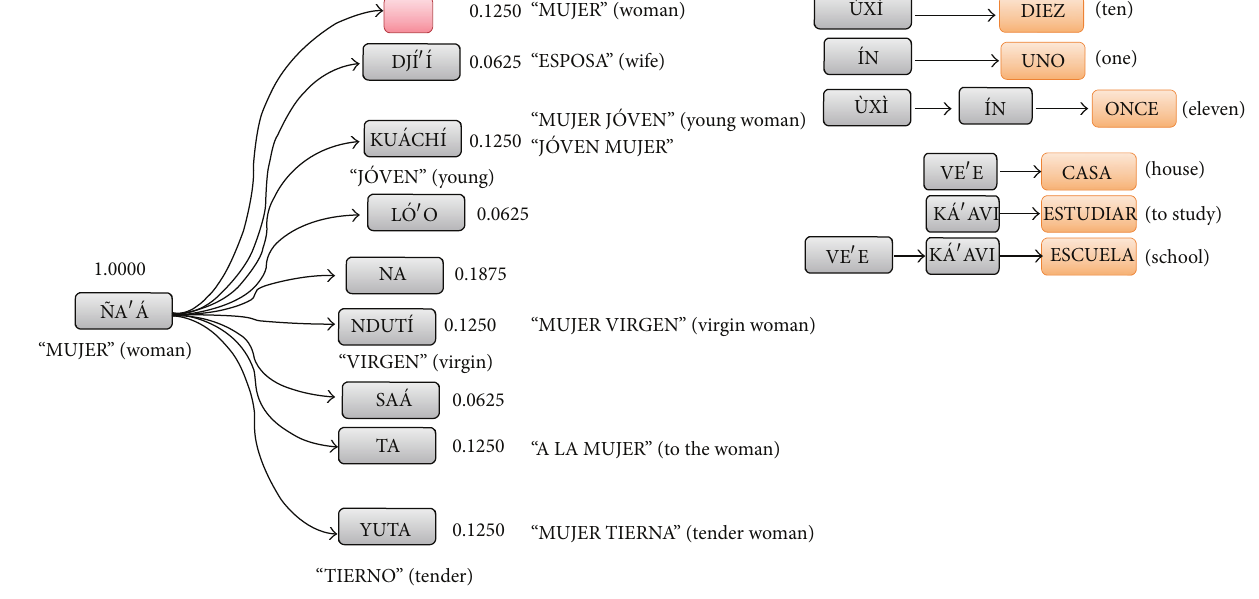
Figure 10: Example of the Mixtec-to-Spanish translation model (TM 𝑋𝑃 ).